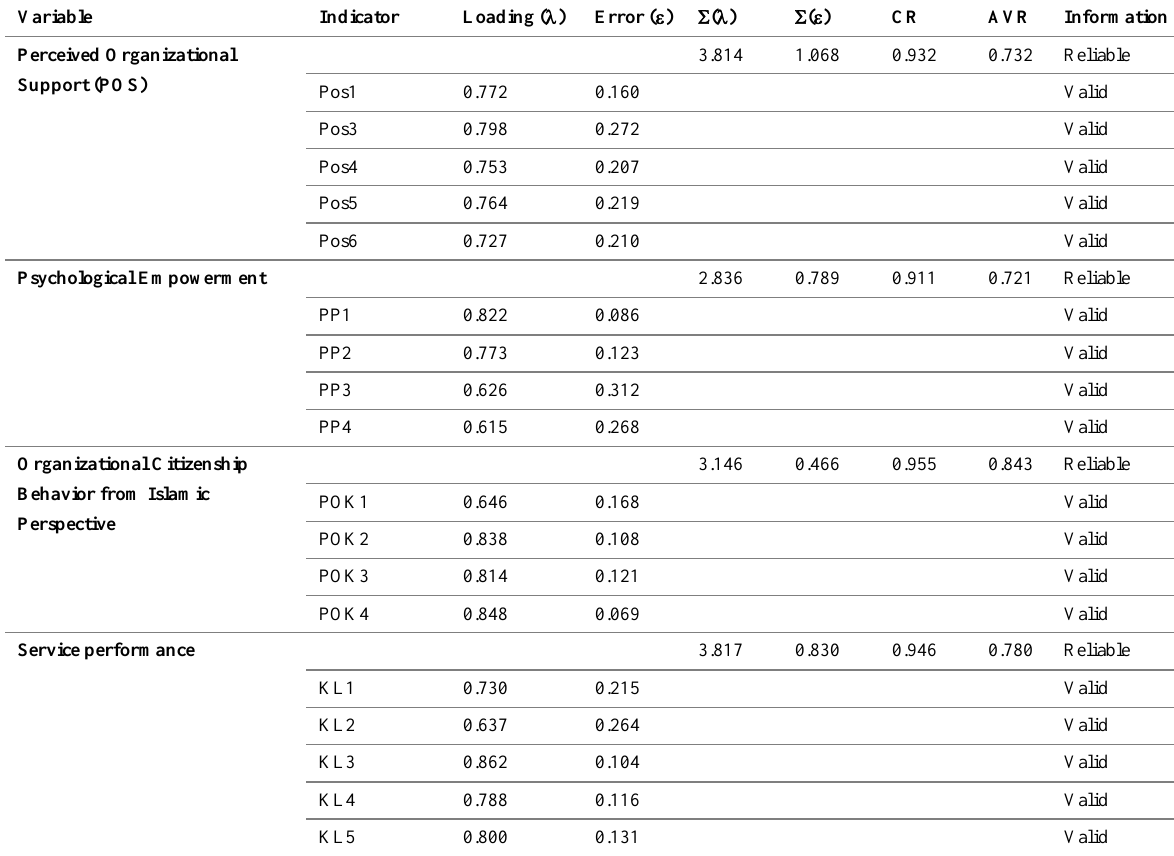
Table 4 : Confirmatory Test Results